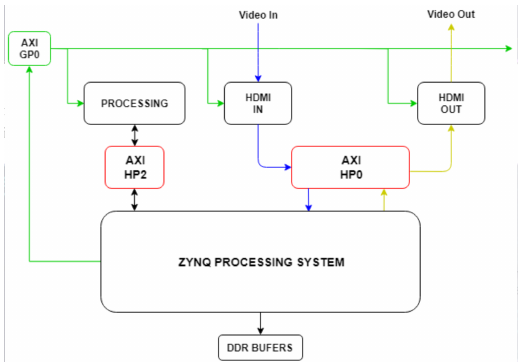
Figure 3. Simplified block diagram of the main IP cores used for the entire design. The green connections represent the configuration and control of the IP cores; blue and yellow colors denote the video input and output lines, respectively; the two red blocks handle the memory buffers communication through the Zynq PS.